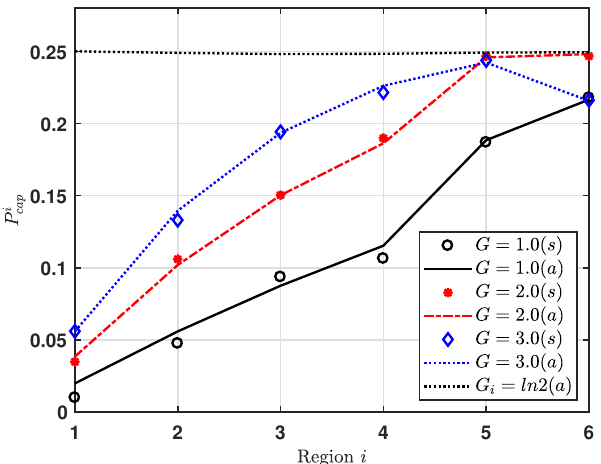
Figure 5. Capture effect probability vs.